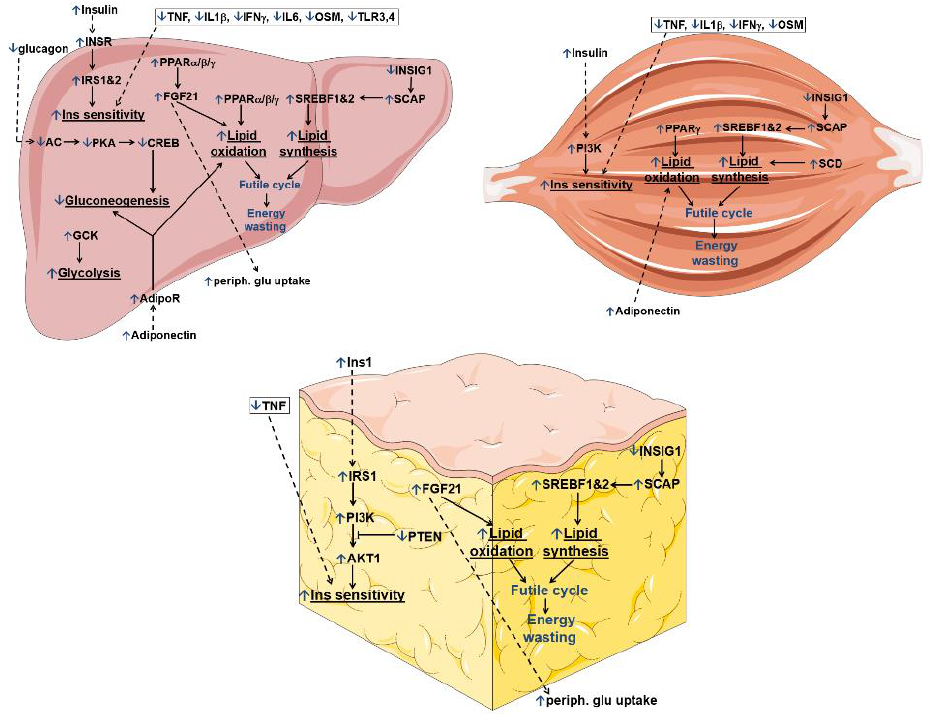
Figure 2. Theoretical order of the IPA transcriptional upstream regulator pathways, which are altered upon BEZ treatment. All IPA upstream regulator pathways of the liver, WAT and skeletal muscle tissues are shown in Figure 1. This figure summarizes those pathways, which are possibly involved in insulin (Ins) sensitivity, glucose as well as lipid metabolism. Blue “ ↑ ” or “ ↓ ” arrows show BEZ-activated or BEZ-inhibited pathways. Black arrows represent direct, whereas dashed arrows denote indirect regulations.